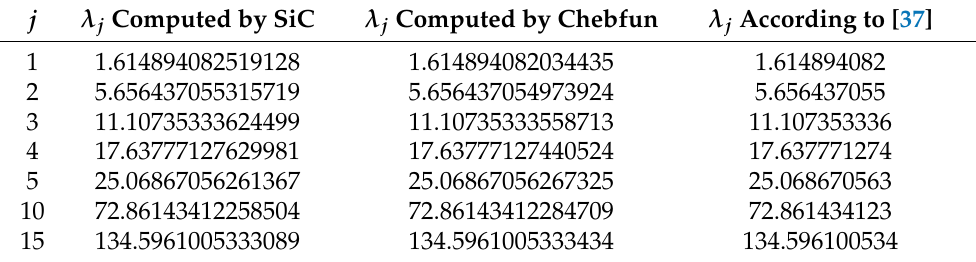
Table 4. Some eigenvalues of the Schrödinger problem (13) computed by three different methods. j λ j Computed by SiC λ j Computed by Chebfun λ j According to